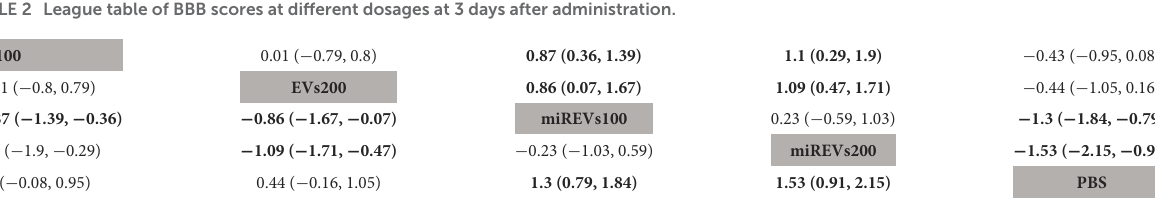
TABLE 2 League table of BBB scores at different dosages at 3 days after